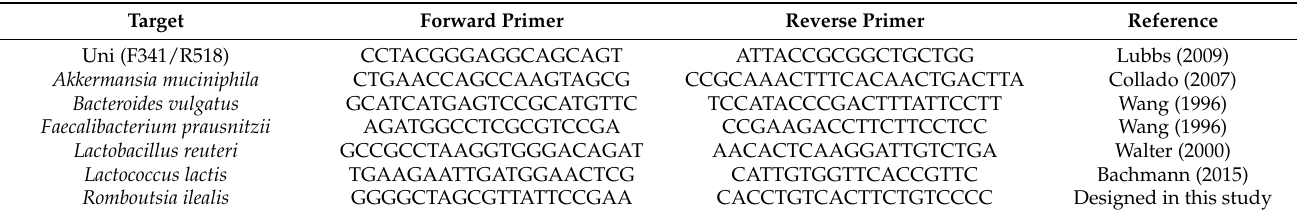
Table 2. Sequences of primers used for bacterial